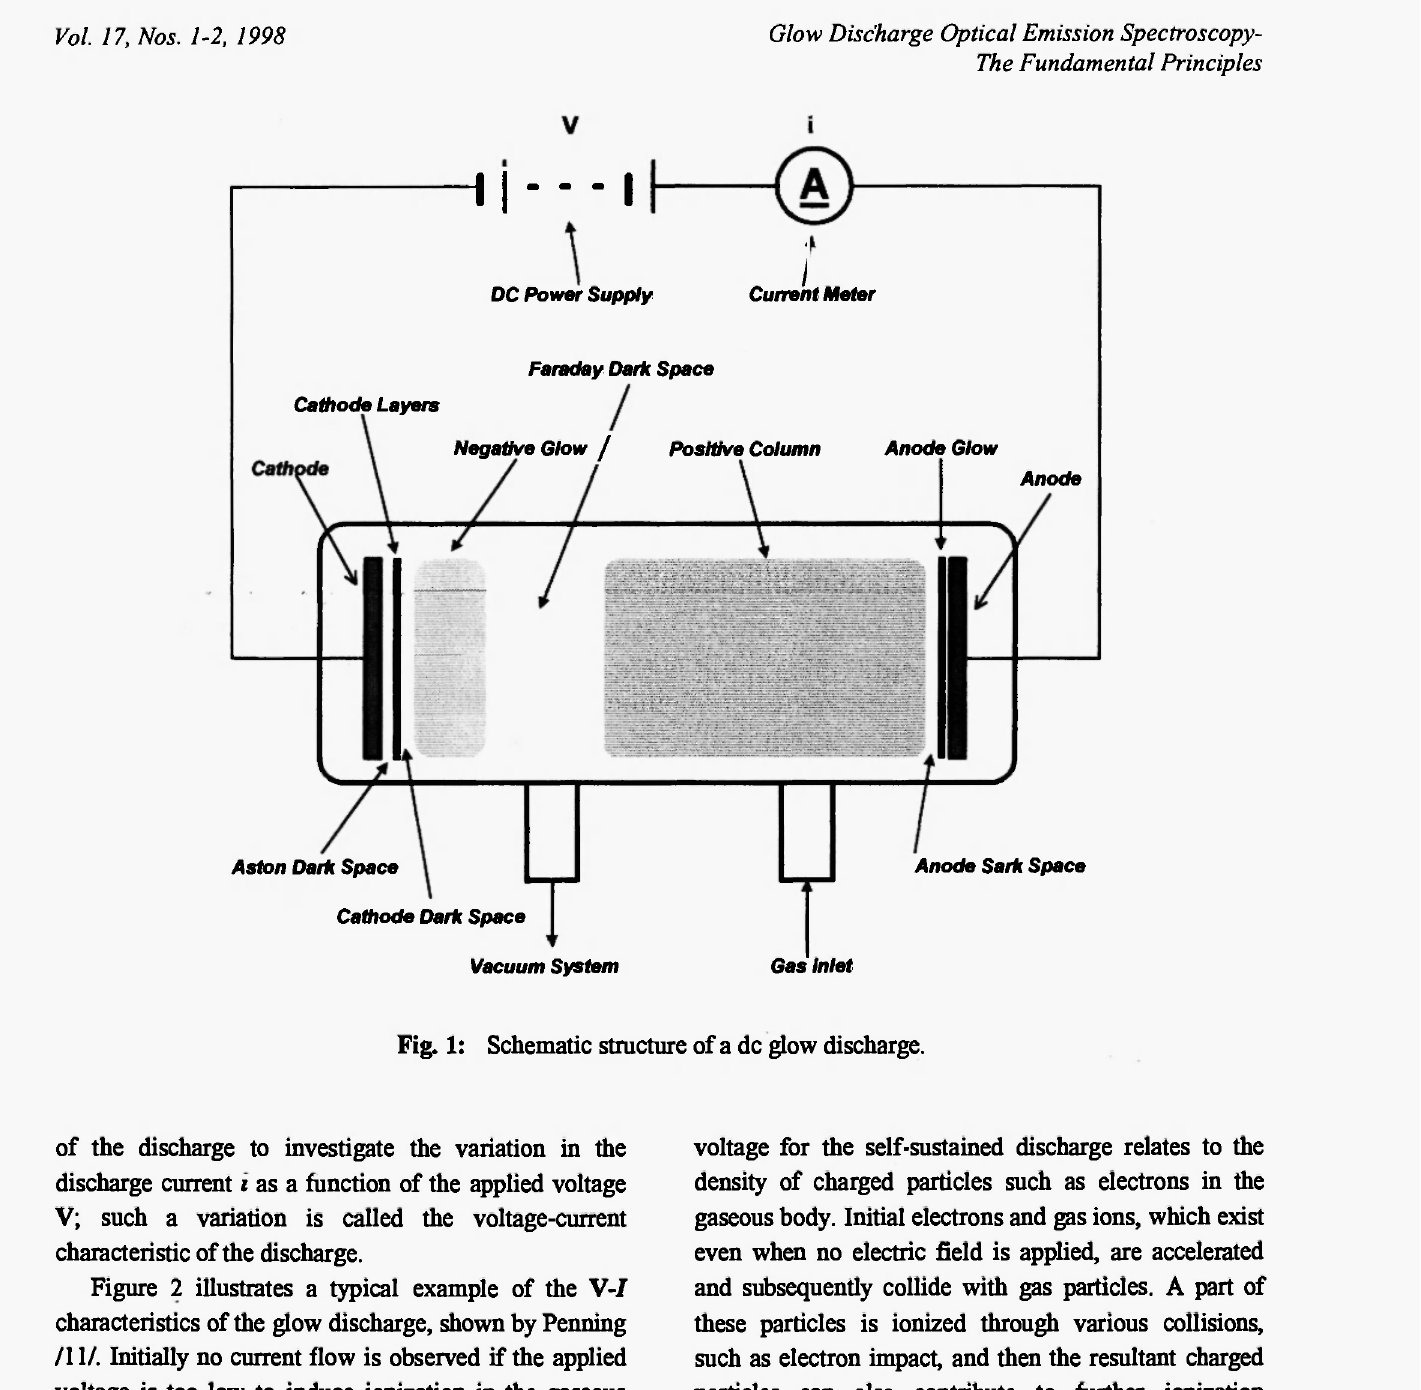
Fig. 1: Schematic structure of a dc glow